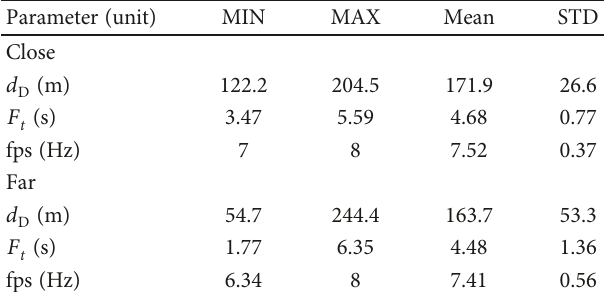
Table 1: Basic essential parameters of S&A system application . Parameter (unit) MIN MAX Mean STD Close d D